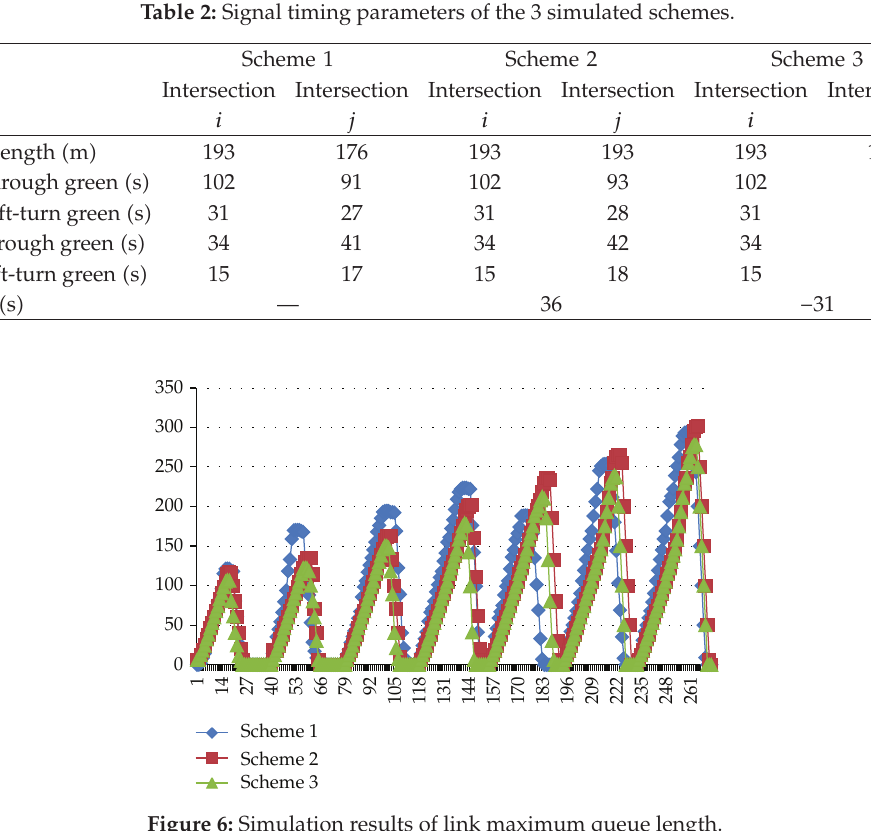
Figure 6: Simulation results of link maximum queue length.